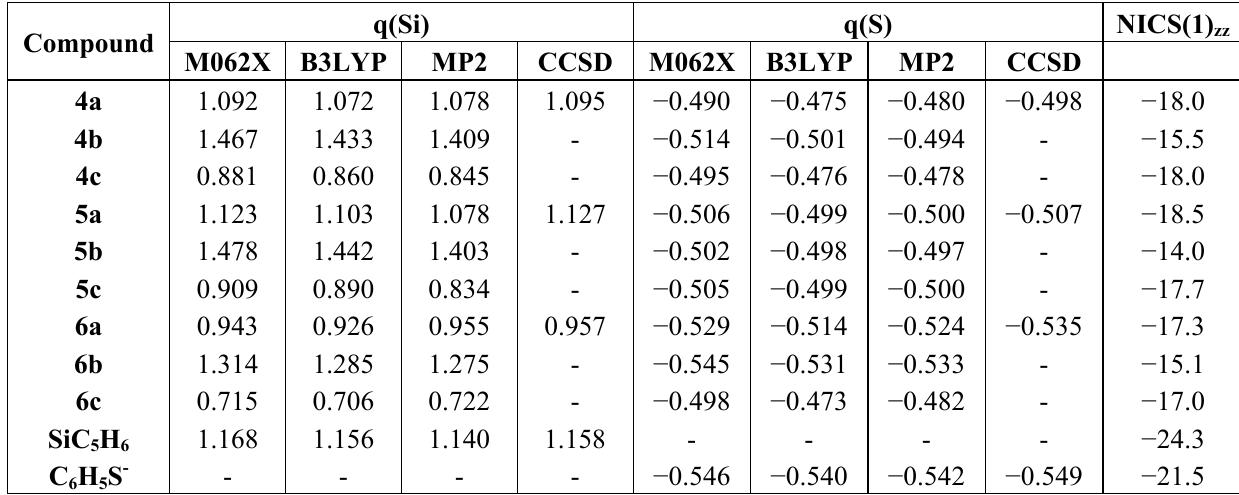
a Atomic charges calculated by natural population analysis (NPA) at the four different levels, and nucleus